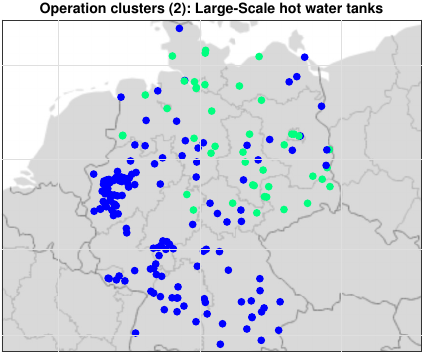
Figure 19. Operation clusters: operational time series of hot water tanks clustered in two groups (blue, green) and plotted to their respective location (scenario: